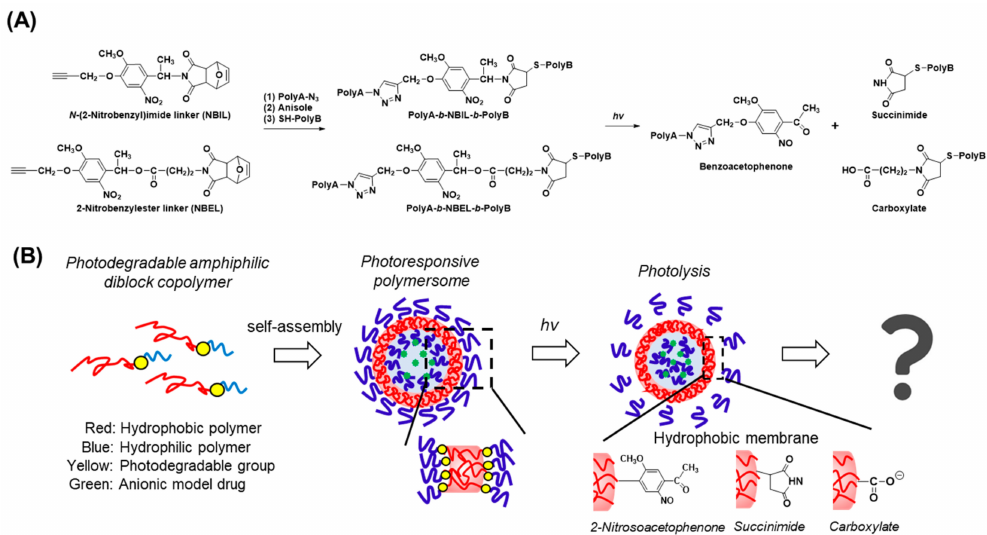
Figure 1. Research strategy of the present study. ( A ) Synthesis and photolysis